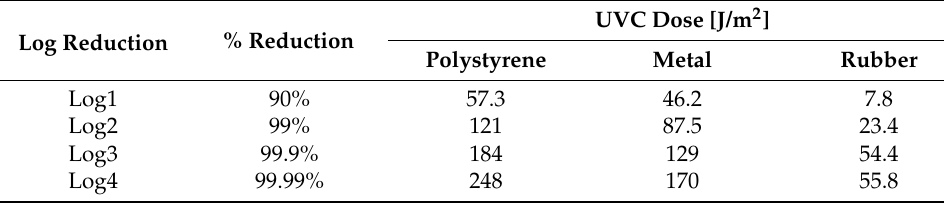
Table 2. UVC dose for different materials and % of virus infectivity reduction.